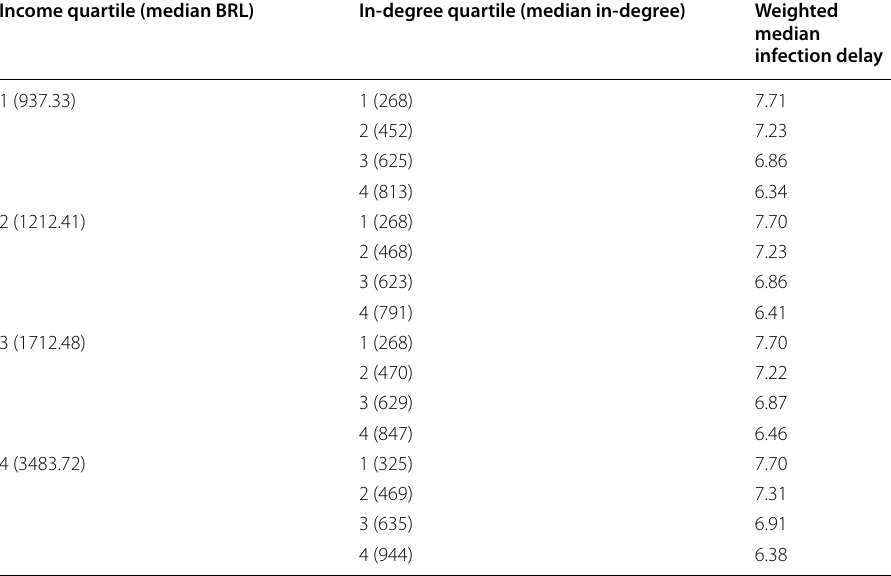
Median income per capita (Brazilian Real per Month) and in-degree centrality within each quartile subgroup is shown. The differences in weighted median infection delay values across in-degree centrality quartiles are statistically significant ( p < 0.01 )